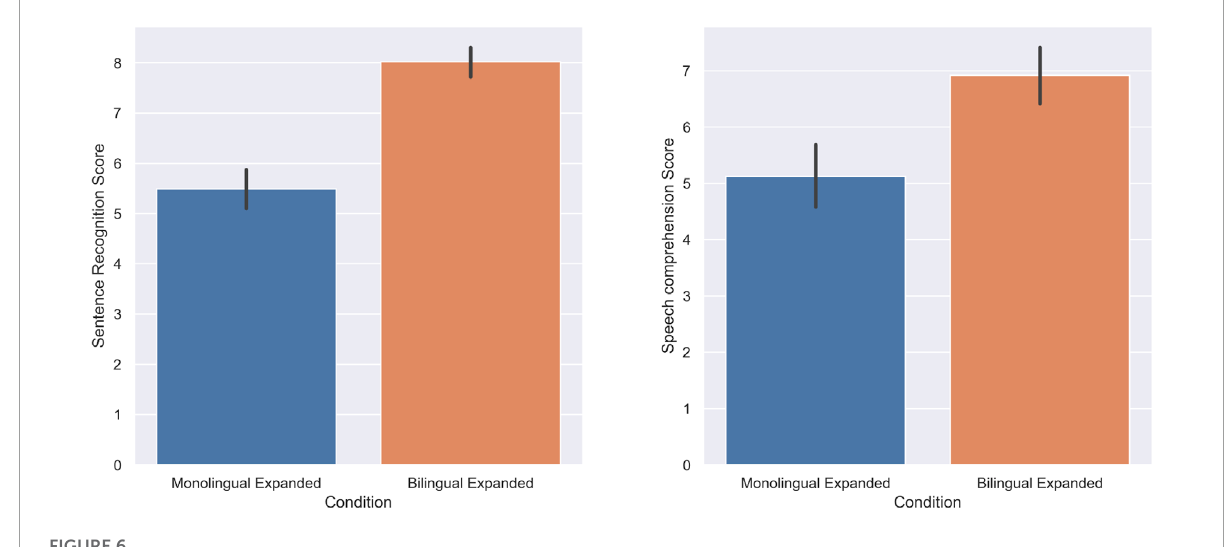
FIGURE 6 Experiment 4: Expanded Monolingual and Expanded Bilingual. The score of subjects in the Sentence recognition (A) and Speech comprehension (B)